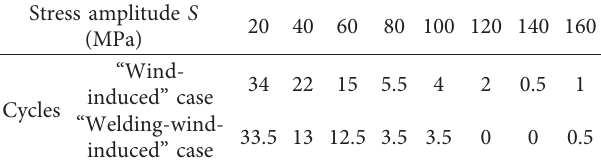
Table 2: Classification data of the stress spectrum.